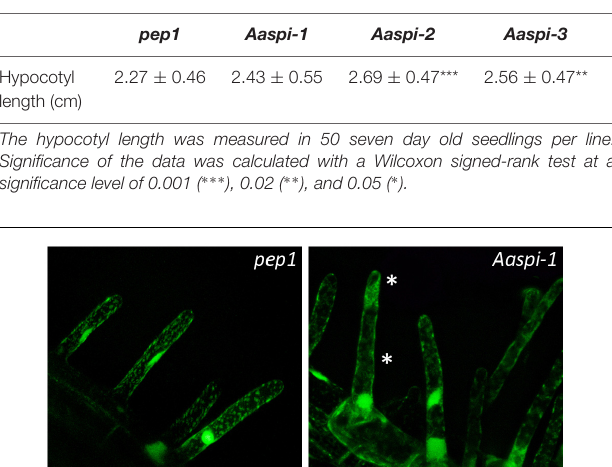
TABLE 2 | The hypocotyl length of pep1 and Aaspi mutants.